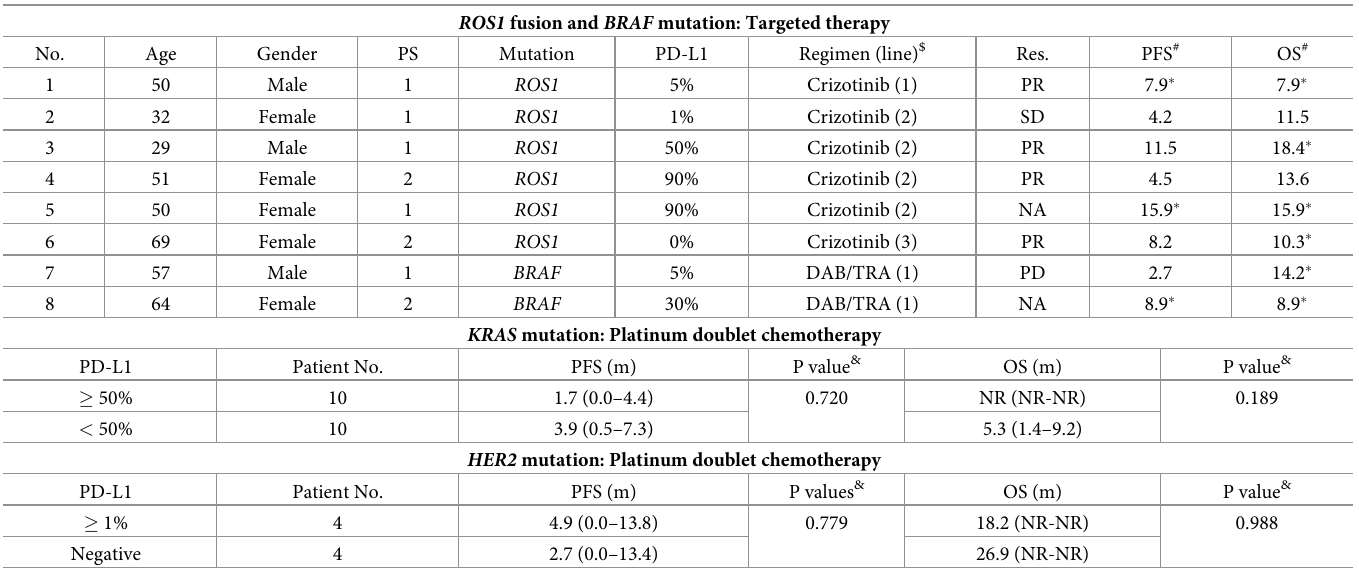
Table 4. PD-L1 expression and the outcome of advanced NSCLC treatment. ROS1 fusion and BRAF mutation: Targeted